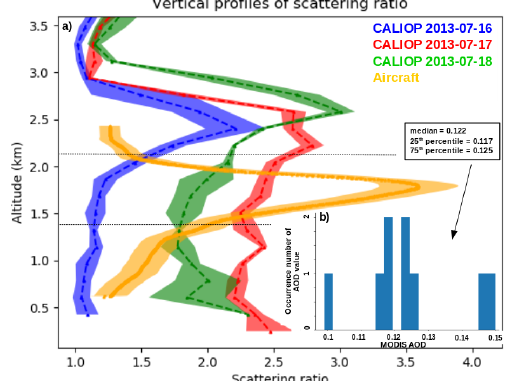
Fig. 8: (a) 20 km average of the backscatter ratio vertical profile from the airborne lidar on July 19 th 6 UT (yellow), CALIOP on July 16 th 19 UT (blue), on July 17 th 19 UT (red) and on June 18 th 5 UT (green). (b) MODIS AOD distribution in 550 the ± 70 km area around the aircraft